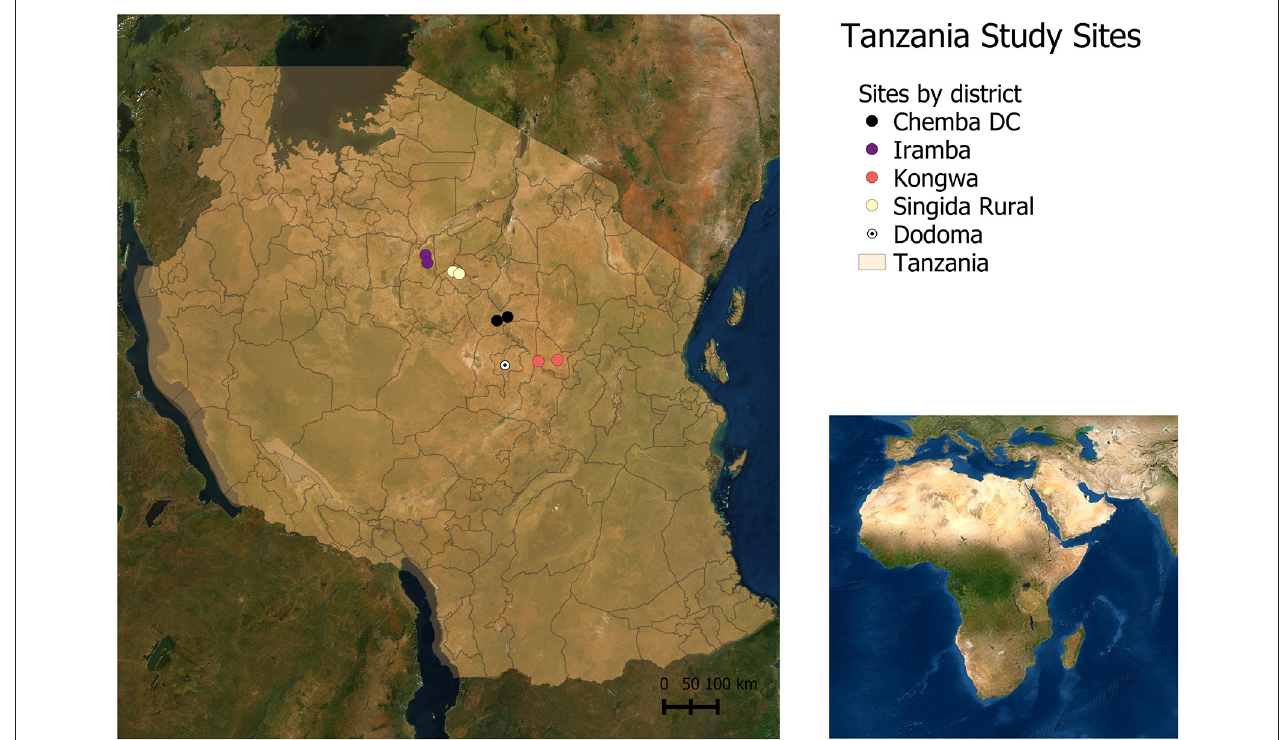
FIGURE 1 | Study sites in